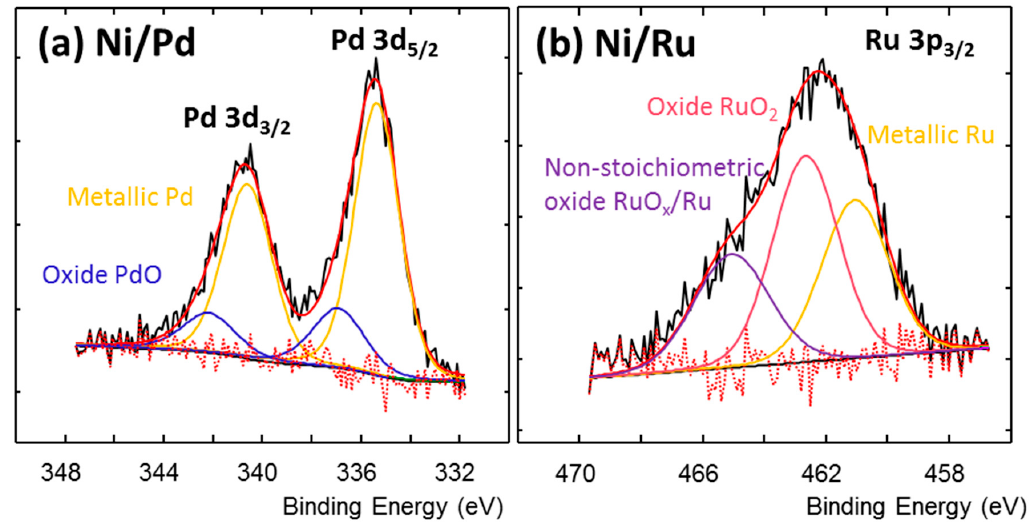
Figure 4. The high-resolution X-ray photoelectron spectroscopy (XPS) spectra of ( a ) Pd3p 3 / 2 from the Ni / Pd system and ( b ) Ru3p3 / 2 from the Ni / Ru system. A black line represents the measured data, the red line represents the fitted data, and the dotted red line represents the di ff erence between the measured and fitted data. The individual contributions to the fitted data are represented by the colored lines and were assigned to a specific chemical state.